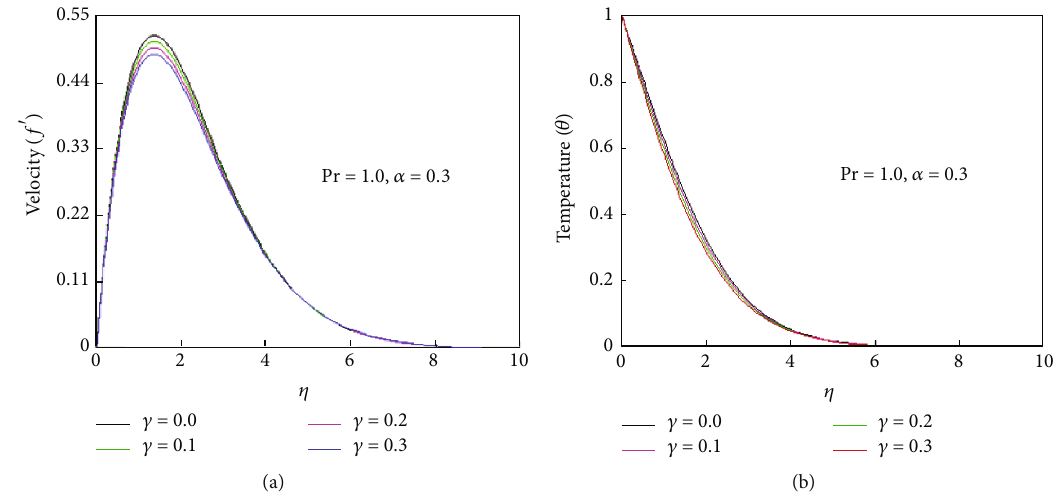
Figure 3: Variation of (a) f ′ , the velocity pro fi les, and (b) θ , the dispensation of temperature in oppose to the distance η that is dimensionless for distinct values of γ , the variation variable of thermal conductivity while Pr = 1 : 0 and α = 0 : 3